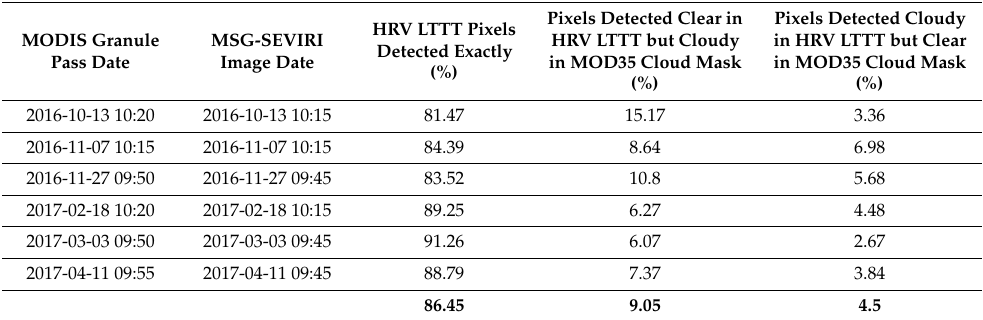
Table 5. Statistical scores of the comparison of the HRV LTTT Cloud Mask with MODIS MOD35 Cloud